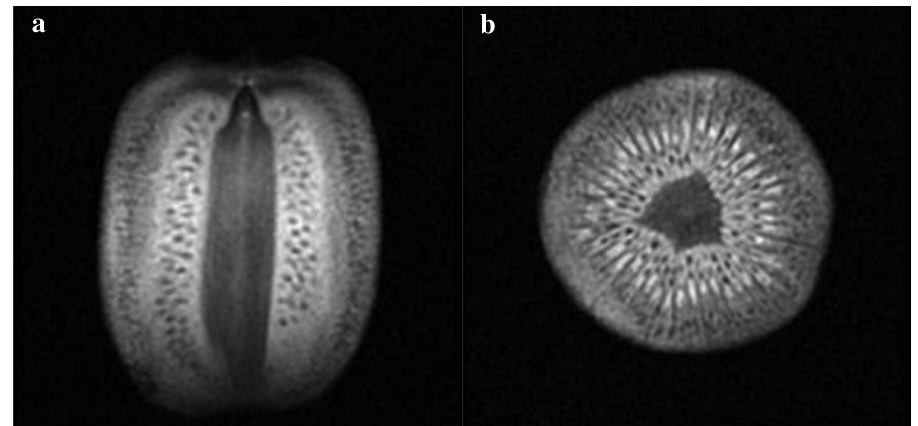
Figure 5. Proton fast spin echo images of a kiwifruit on both ( a ) sagittal plane and ( b ) axial plane acquired using the 16-strut common-mode volume coil at 7T. This imaging result demonstrates the feasibility of the common-mode method for designing volume coils with a lower number of elements but uniform at high